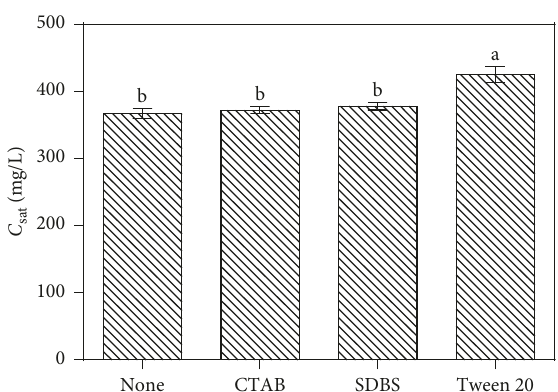
Figure 7: Solubility of BPA in absence and presence of the sur- factants. The bars indicate the standard error of triplicates, and different letters indicate significant difference ( p < 0 . 05).